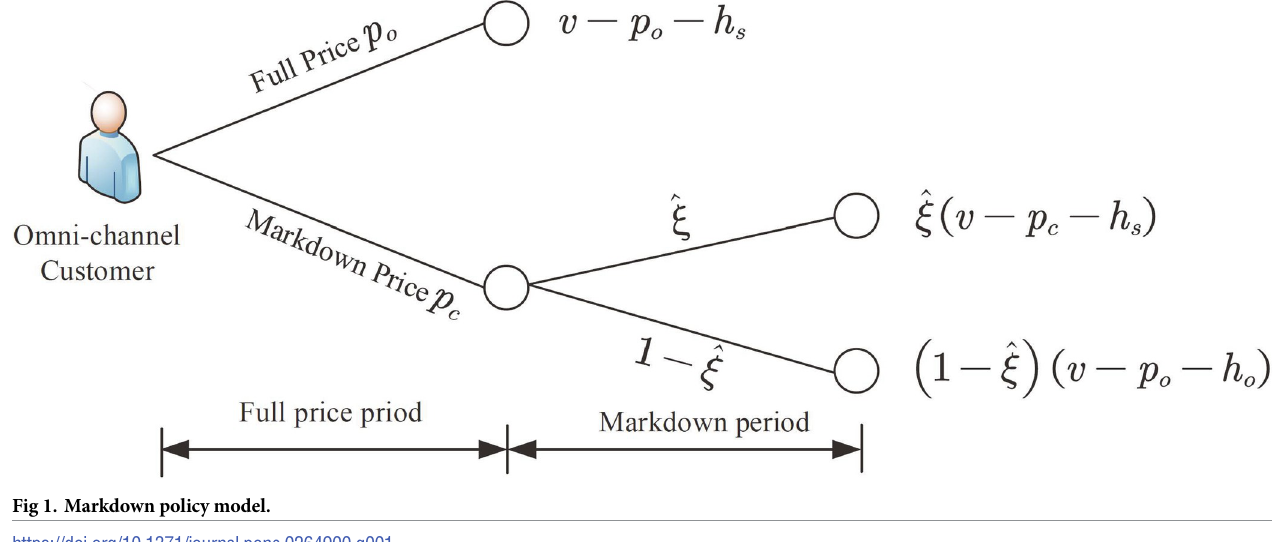
Fig 1. Markdown policy